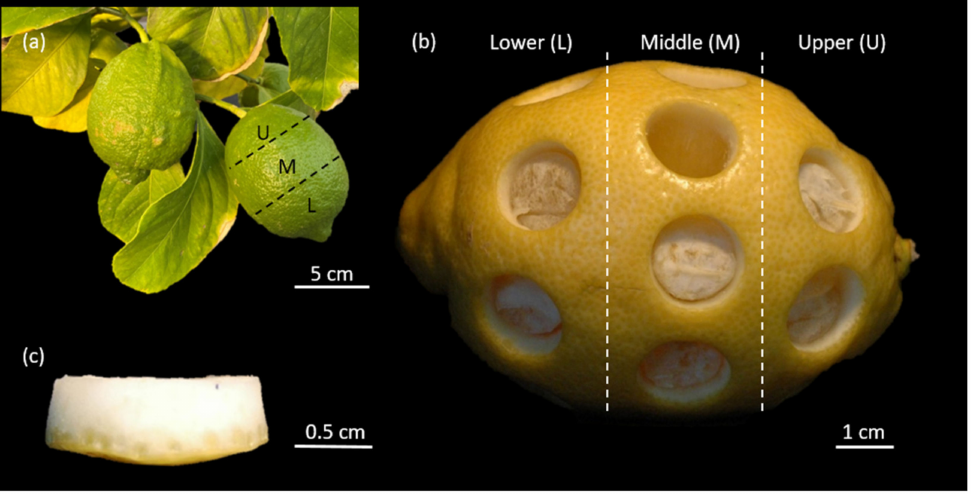
Figure 2. Lemon ( Citrus × limon ) fruit divided into three parts (lower (L), middle (M) and upper part (U)), ( a ) showing unripe lemon fruits in their natural orientation on the tree. ( b ) Ripe Citrus × limon with samples cut out using a cork borer. ( c ) Freshly cut-out sample of the peel of Citrus × limon